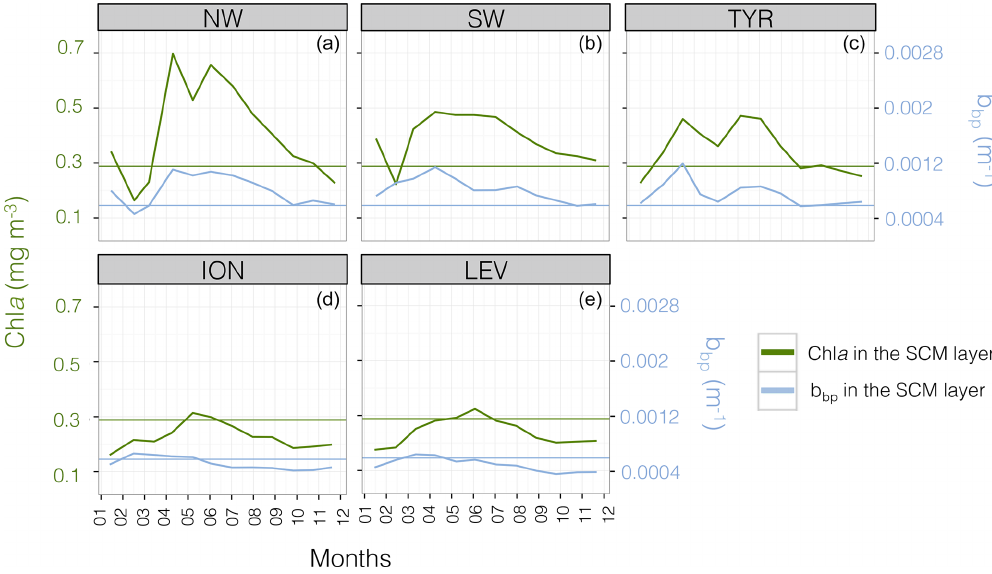
Figure 4. Monthly median value of the chlorophyll a concentration, Chl a (in green) and the particulate backscattering coefficient, b bp (in blue) in the SCM layer for the five Mediterranean regions considered in this study. The annual median of Chl a (0.28mgm − 3 ) and b bp (5 . 8 × 10 − 4 m − 1 ) calculated for the SCM layer and over the entire Mediterranean Sea are indicated by the green and blue horizontal lines. Note the different scales of the y axes in panels (a–e)